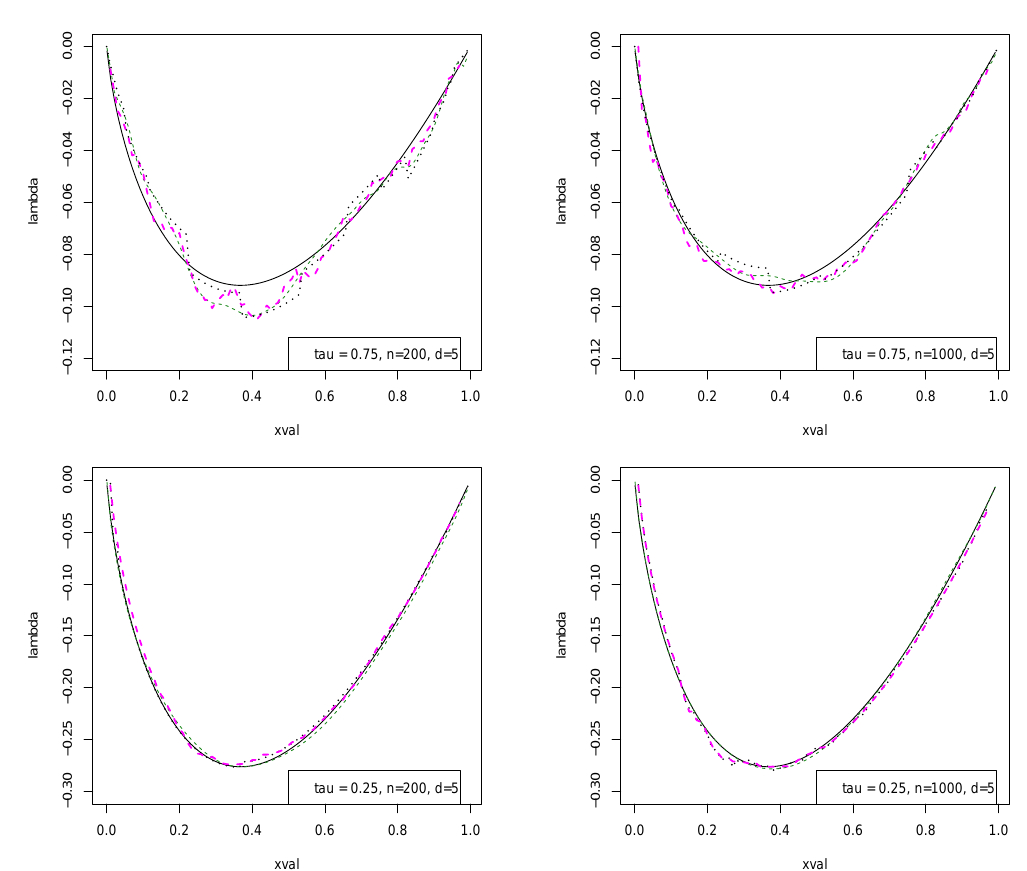
Figure 11. Estimation of λ function. Black: theoretical λ function. Dark green dashed line: b λ G ( u ) (estimator proposed by Genest et al. [25]), Black dotted line: b λ ( u ) (i.e., our estimator using Equation (28) ). Violet dotted-dashed line: b λ ∗ ( u ) (i.e. our estimator using Equation (29) ). Parameters setting : n = 200 , (right column) and n = 1000 (left column), d = 5 . Kendall’s tau parameter is τ = 0 . 75 ( θ = 4 ) (upper row) and τ = 0 . 25 ( θ = 1 . 333 ) (bottom